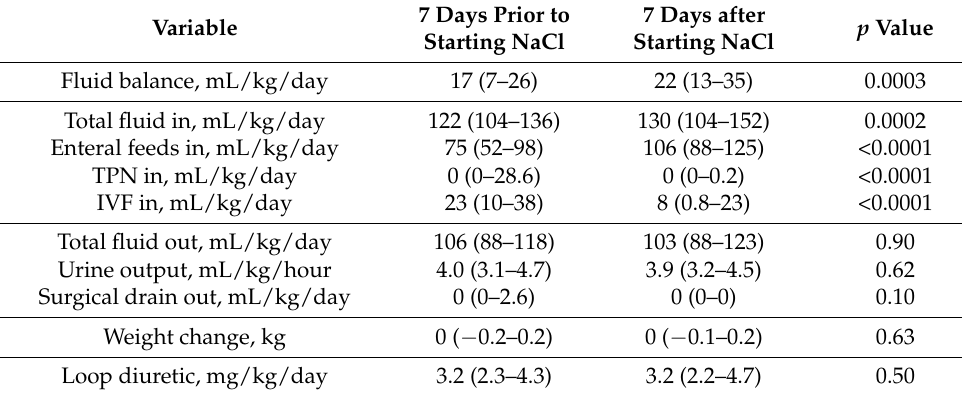
Table 2. Fluid balance and diuretic dose before and after NaCl